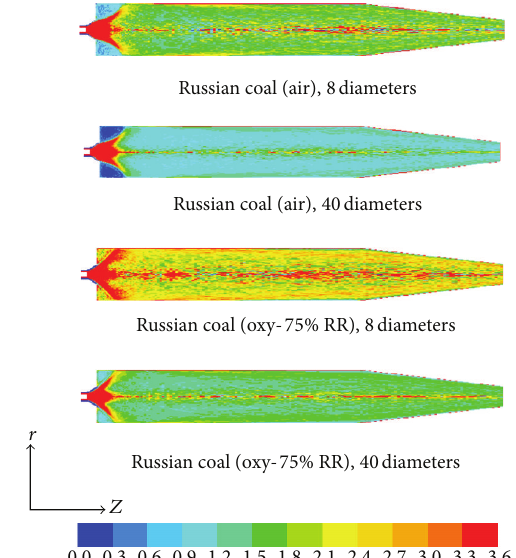
Figure 14: Sensitivities of the particle extinction coefficients ( 𝜎 𝑝 + 𝑘 𝑝 ) (in m −1 ) to the number of diameter intervals (or resolution in the R-R distribution) during combustion of Russian coal.